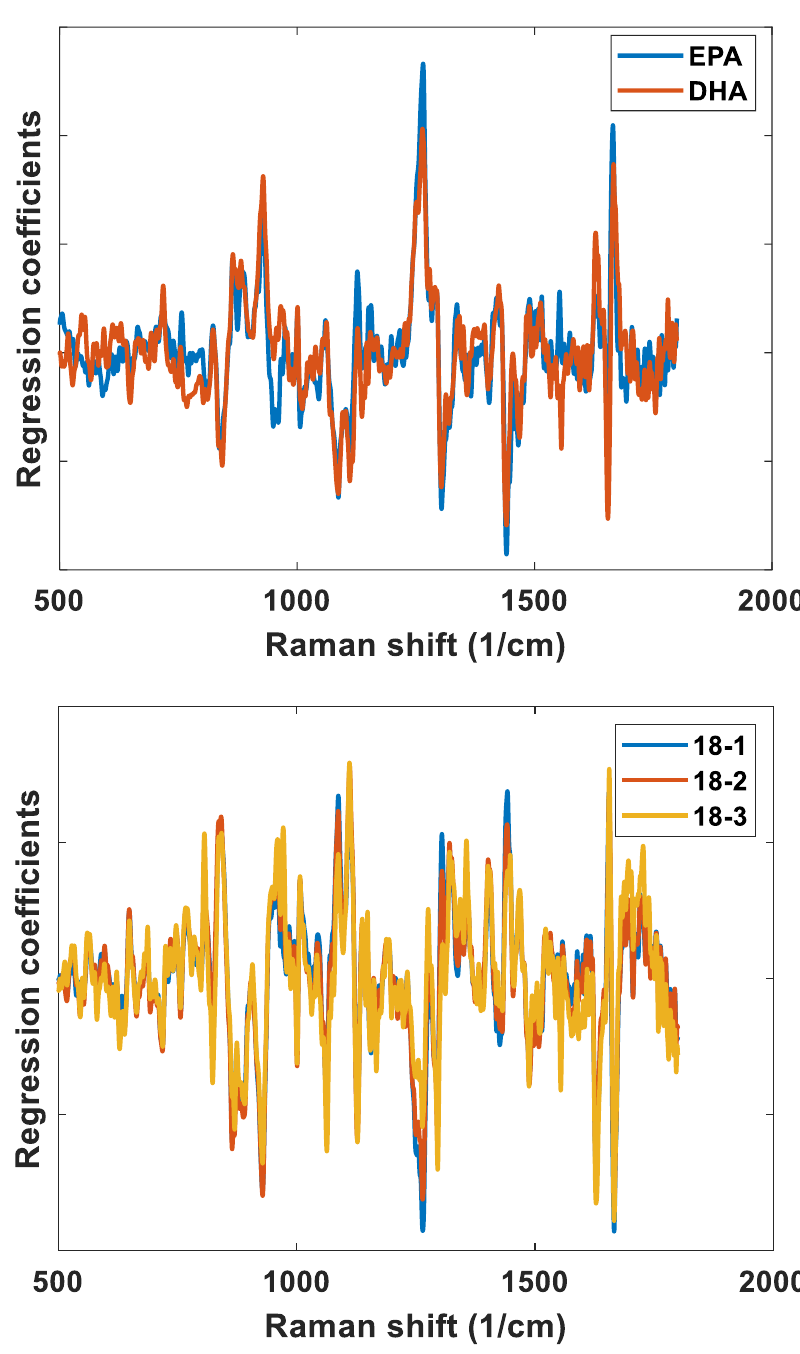
Figure 4. Regression coefficients obtained from Raman regression models of EPA and DHA ( 4a, upper plot) , and 18:1(n-9), 18:2(n-6) and 18:3(n-3) ( 4b, lower plot ). All regression coefficients are obtained from regression models using five factors and have been normalized to simplify the